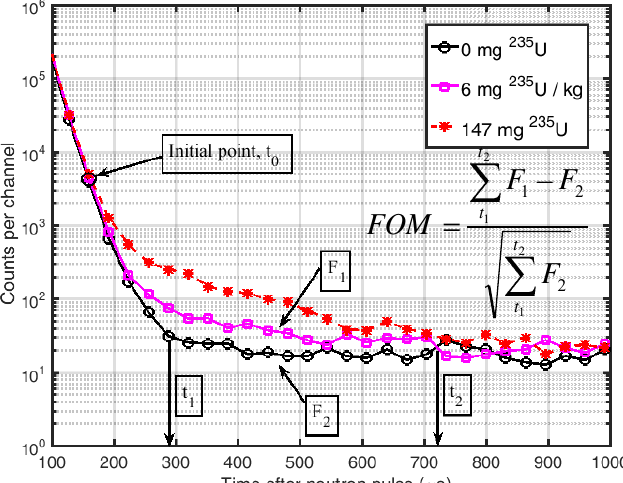
Fig. 2 Example of experimental number of counts per 16-μs channel as function of measurement